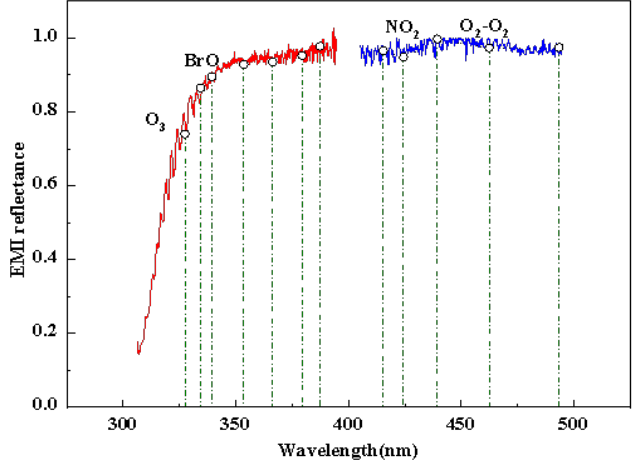
Figure 6. TOA reflectance measured by EMI-2 on 8 February 2022 over Dome